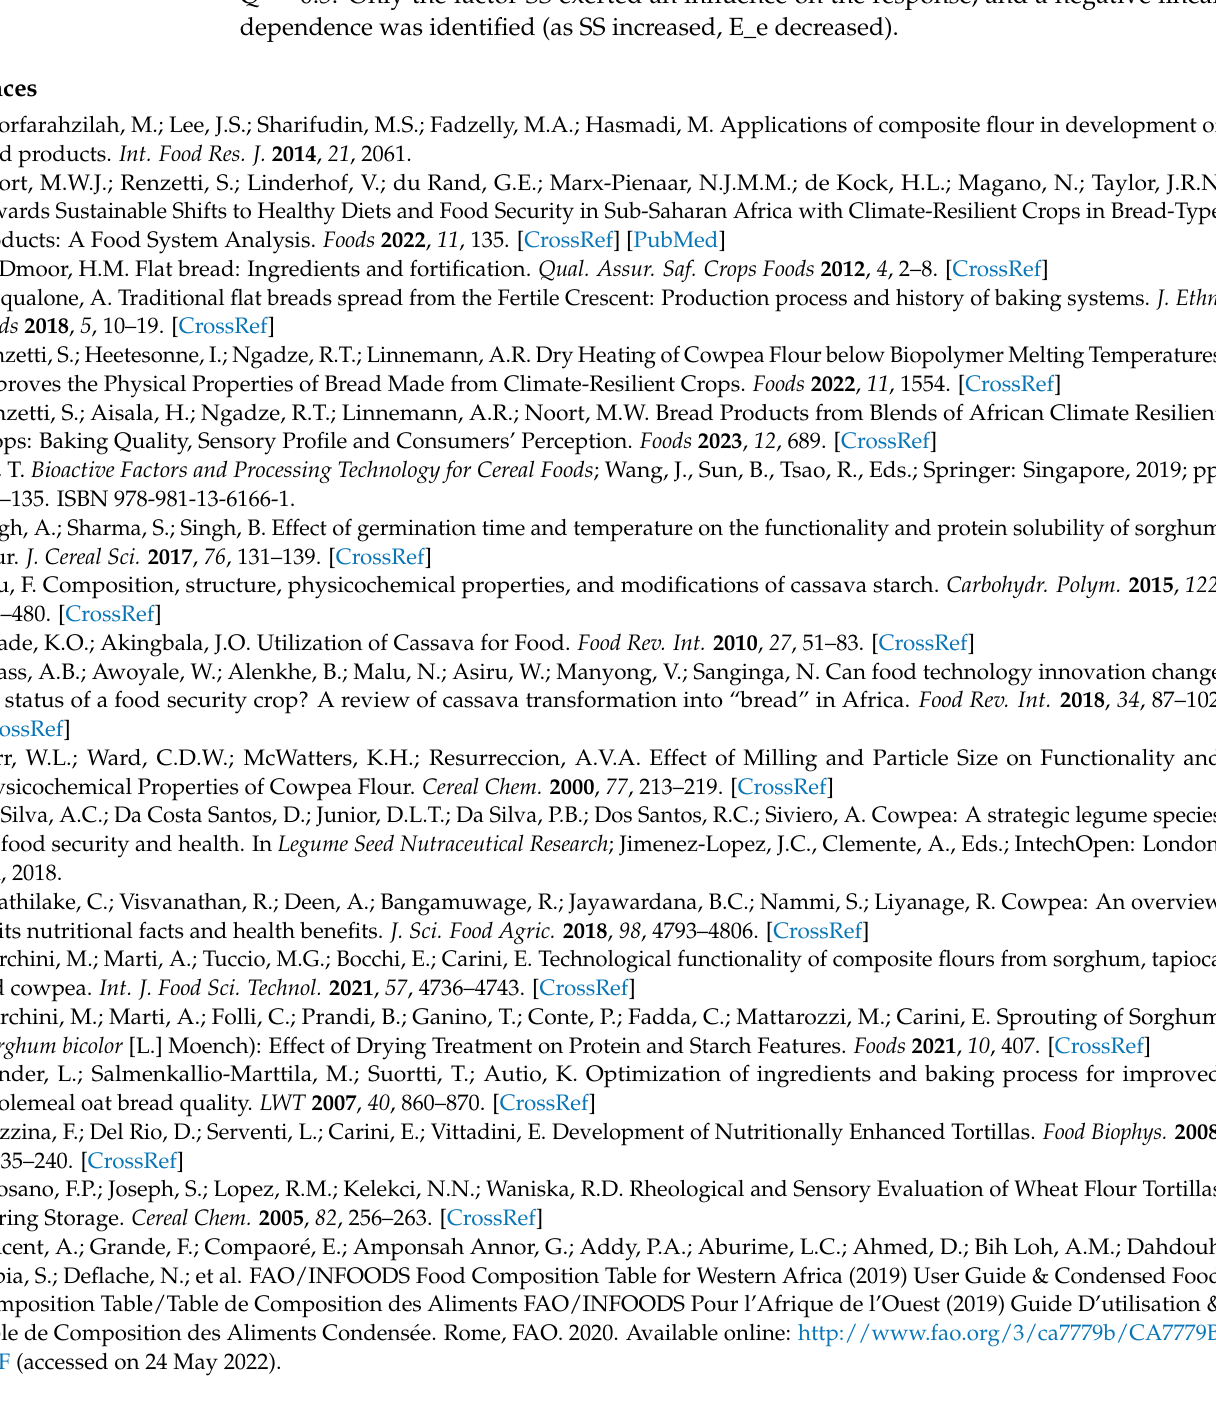
Composition Table/Table de Composition des Aliments FAO/INFOODS Pour l’Afrique de l’Ouest (2019) Guide D’utilisation & Table de Composition des Aliments Condens é e. Rome, FAO. 2020. Available online: http://www.fao.org/3/ca7779b/CA7779B. PDF (accessed on 24 May